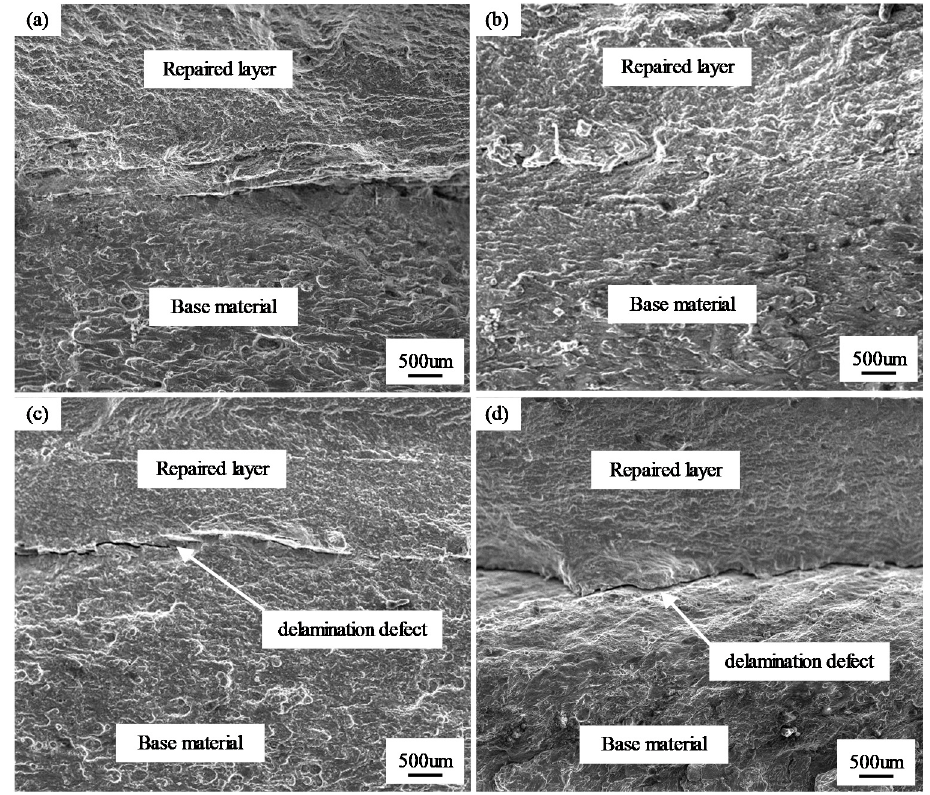
Figure 12. Microstructures of the boundary between the repaired layer and the base material. ( a ) ω = 700 r/min, ν = 110 mm/min, ( b ) ω = 1100 r/min, ν = 150 mm/min, ( c ) ω = 1100 r/min, ν = 110 mm/min, ( d ) ω = 1500 r/min, ν = 110 mm/min.